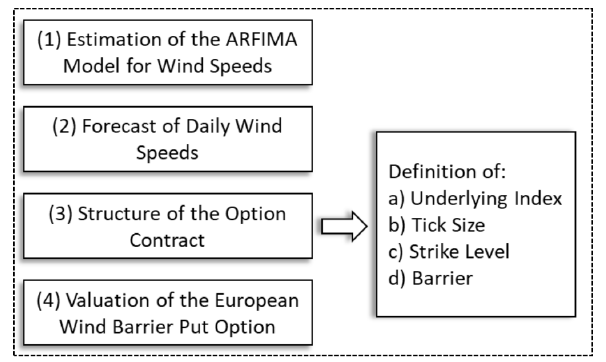
Figure 1. Flow diagram of the methodology to evaluate wind put barrier